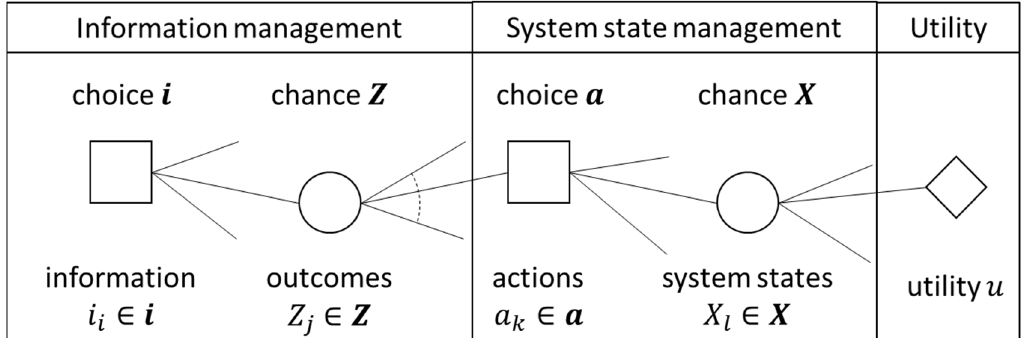
Figure 1. General overview of pre-posterior decision analysis.